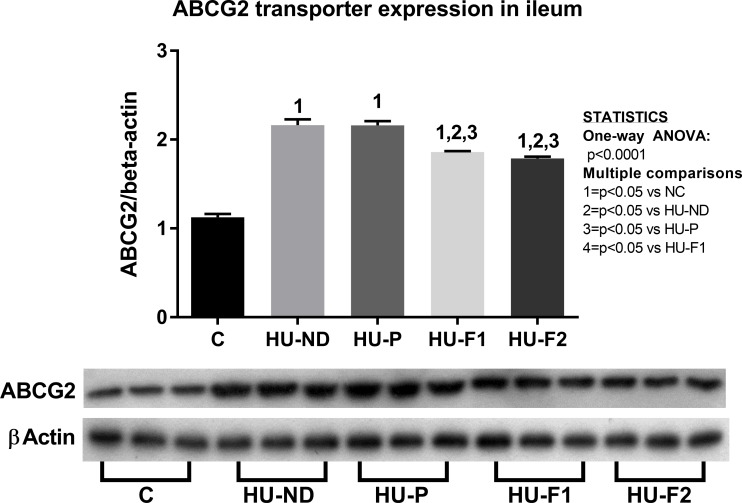
Probiotics supplementation resulted in decreased expression of ABCG2 transporter in the ileum.Hyperuricemia upregulated the expression of ABCG2 by western-blot. Probiotics supplementation prevented ABCG2 overexpression. N = 6 each group.